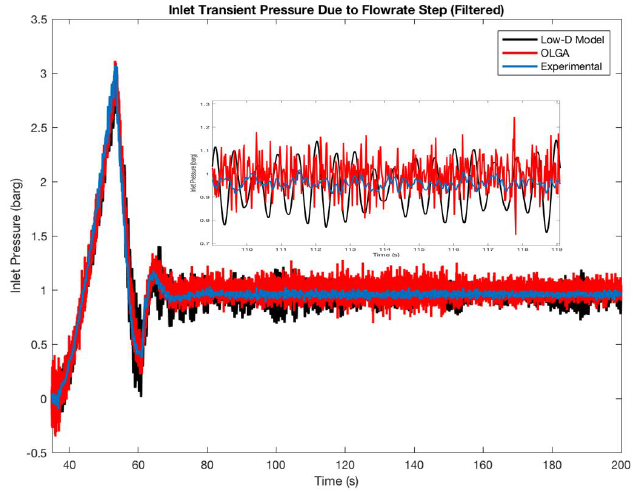
Figure 11. Experimental vs. simulations (Inlet Pressure, liquid/case 3).